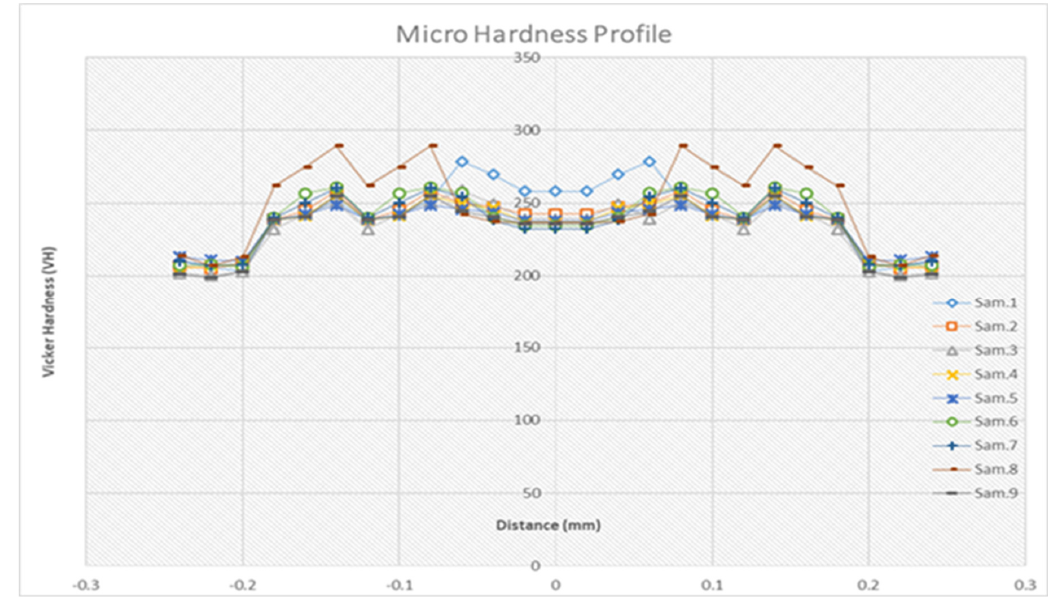
Fig. 8. The Results of the Vickers’s Micro-hardness profile for nine specimens.